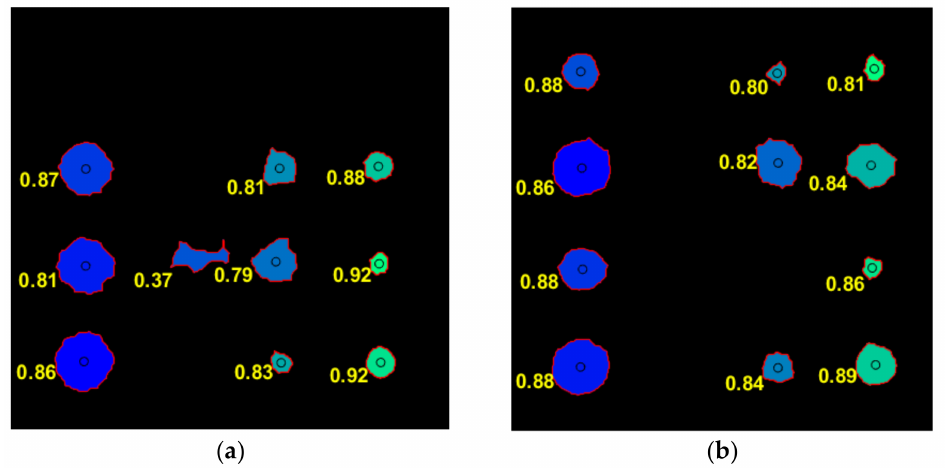
Figure 11. Automatic defect recognition based on a threshold of 0.75 for each image: ( a ) amplitude and ( b )